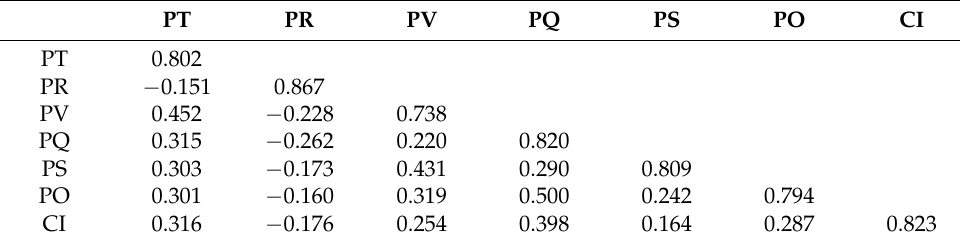
Table 5. Discriminant validity for the measurement